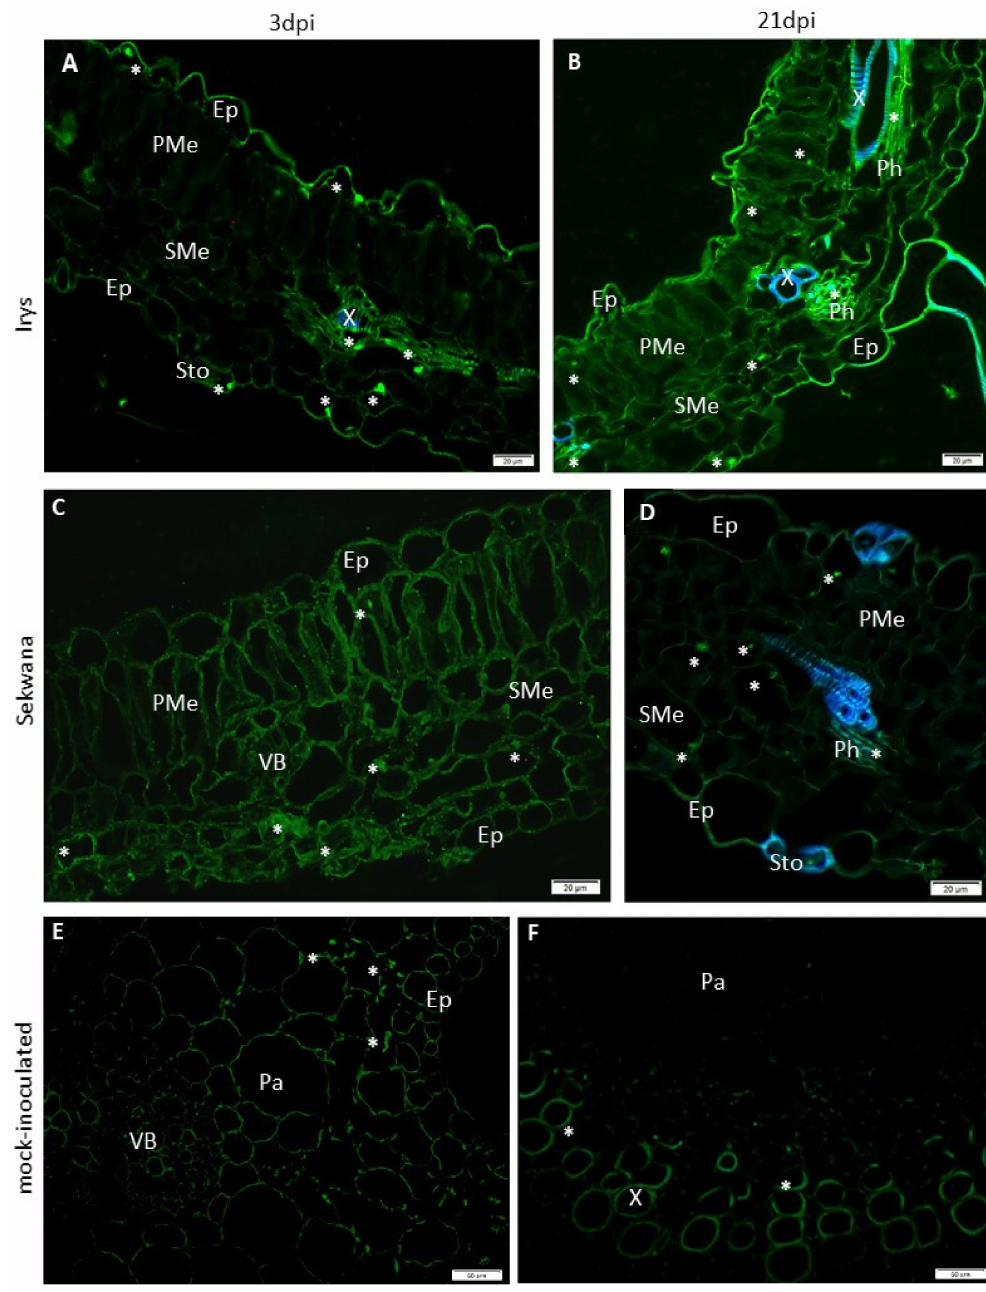
Figure 8. Immunofluorescence localization of HSC70 in potato leaves of Irys ( A , B , E ) and Sekwana ( C , D , F ) inoculated with PVY NTN . ( A ) HSC70 (*) points of green fluorescence signal in the epidermis (Ep) and vascular bundle (VB) at 3 dpi. Scale bar: 20 µ m. ( B ) HSC70 detection (*) in the inoculated leaf tissue at 21 dpi, mainly in the vascular bundle (VB). Autofluorescence of tracheary elements detected by DAPI. Scale bar: 20 µ m. ( C ) HSC70 fluorescence signal (*) in mesophyll at 3 dpi in Sekwana. Scale bar: 20 µ m. ( D ) Points of green fluorescence due to HSC70 signal (*) in the spongy mesophyll (SMe) and phloem (Ph) tissues at 21 dpi. Autofluorescence of tracheary elements and cell walls of stomata are detected by DAPI. Scale bar: 20 µ m. ( E ) HSC70 (*) in the parenchyma (Pa) and epidermis (Ep) of mock-inoculated Irys. Scale bar: 50 µ m. ( F ) HSC70 (*) in xylem tracheary elements (X) in mock-inoculated Sekwana. Scale bar: 50 µ